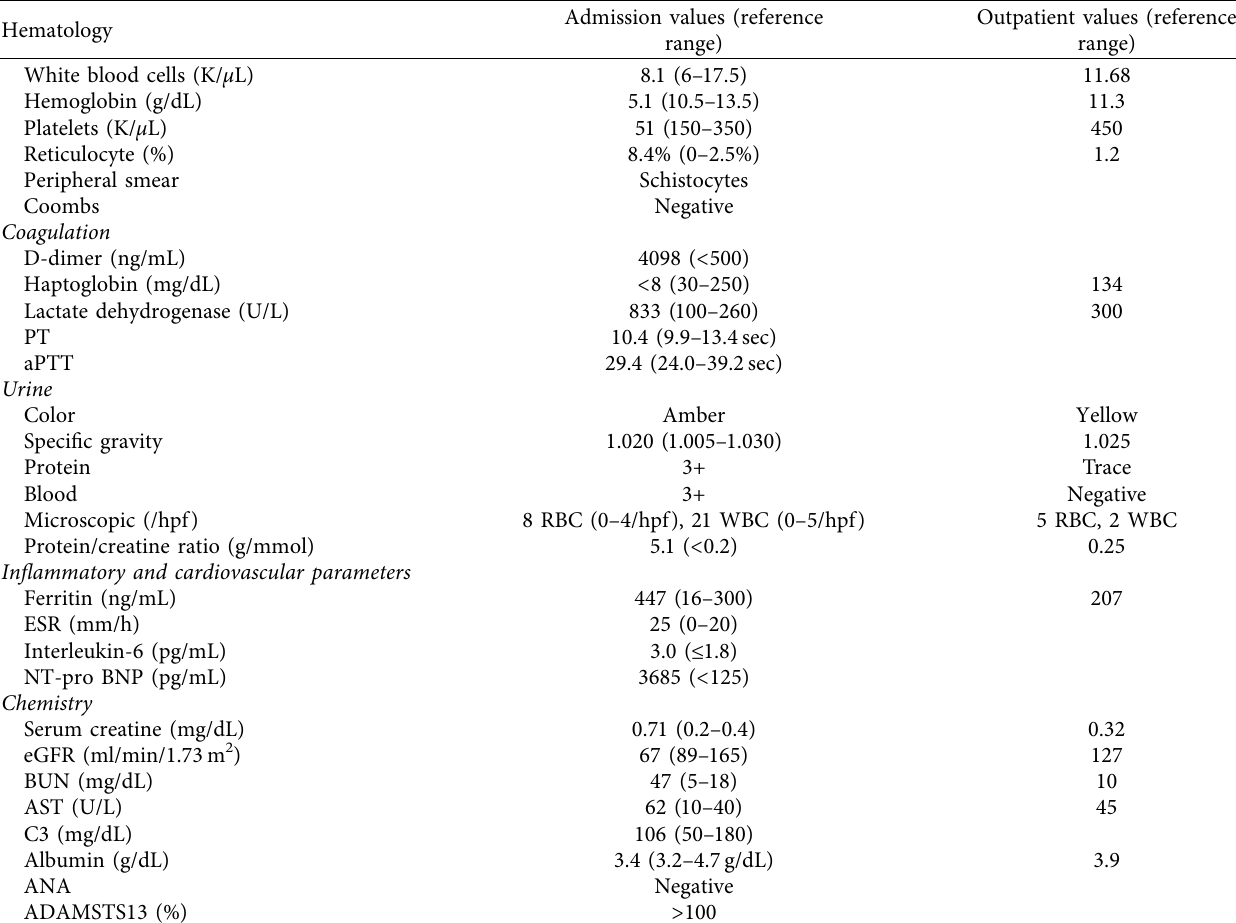
Table 1: Pertinent laboratory data on